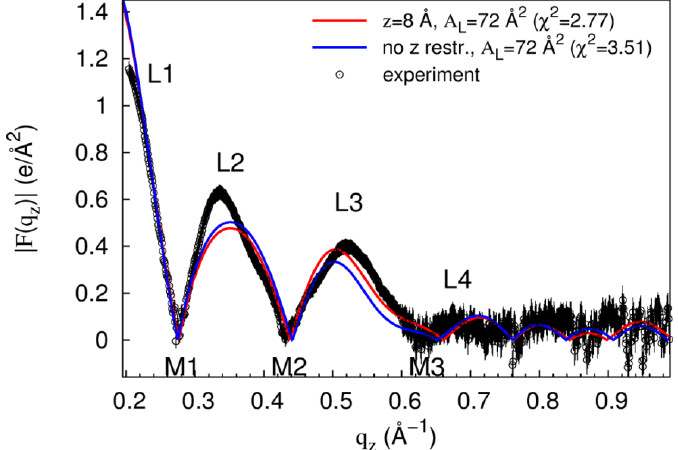
Figure 10. Changes in |F(q z )| upon release of peptide restraint. Black circles and error bars are experimental data for DOPC:DOPE (1:1) with a Tat 47–57 mole fraction of 0.015. Red line is |F(q z )| from the simulation at z = 8 Å 2 , A L = 72 Å 2 , x = 0.015 with the smallest χ 2 value. Blue line is |F(q z )| after releasing the restraint on peptide insertion depth.